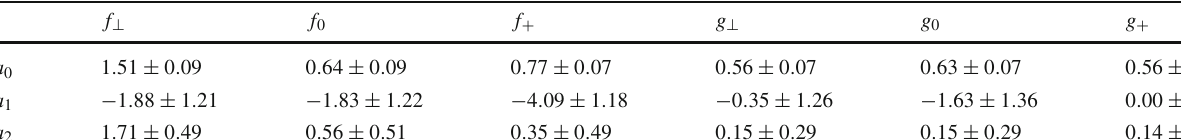
Table 3 Results for the z-expansion parameters describing (cid:5) c → (cid:5) form factors with statistical errors